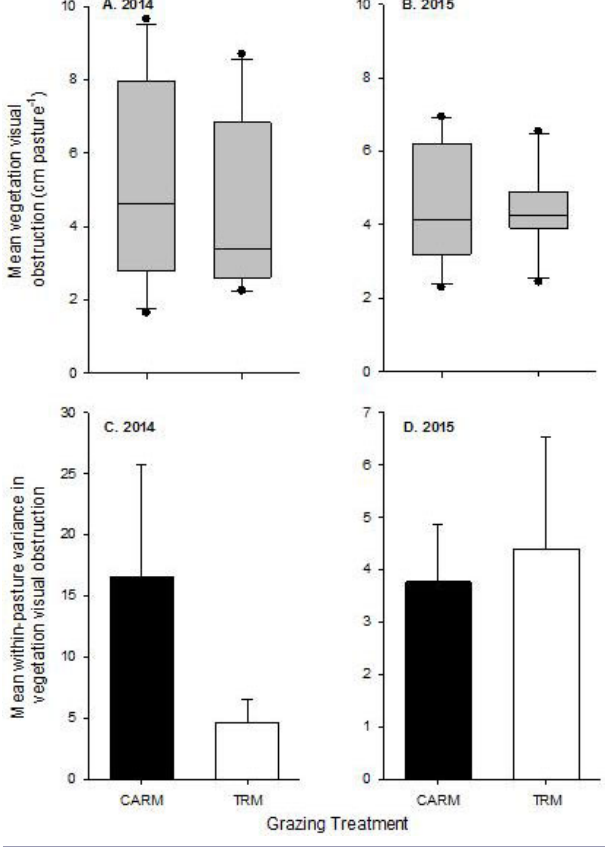
Fig. 5 . Boxplots illustrating variability in vegetation structure among the 10 pastures in each treatment in 2014 (A) and 2015 (B), and bar graphs depicting the mean within-pasture variability in vegetation structure averaged across the 10 pastures in each treatment in 2014 (C) and 2015 (D). In both years, among-pasture variability was greater in collaborative adaptive rangeland management (CARM) than traditionally managed treatment (TRM), as indicated by the wider range of values in the CARM boxplots in (A) and (B). Within-pasture variability was marginally greater in CARM pastures in 2014 ( P = 0.065), but similar across treatments in 2015 ( P = 0.45). These data informed stakeholder struggles to prioritize objectives to achieve vegetation heterogeneity at different spatial